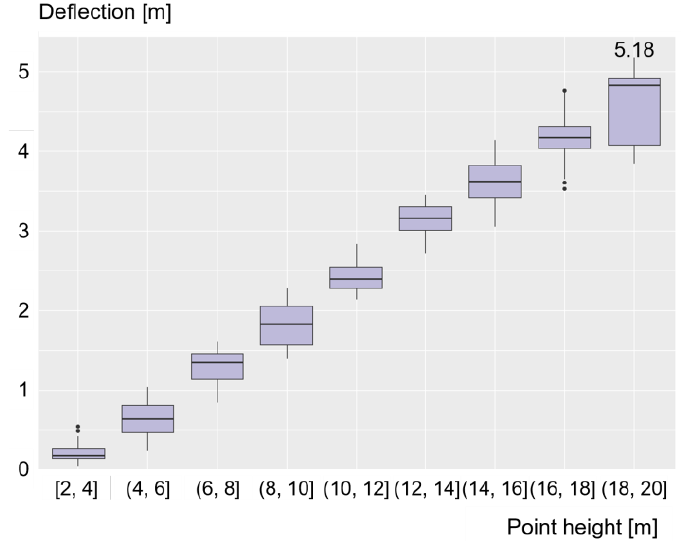
Figure 7. The relationships between tree deflection and the height of each point of the tree at a wind speed of 30 m/s.